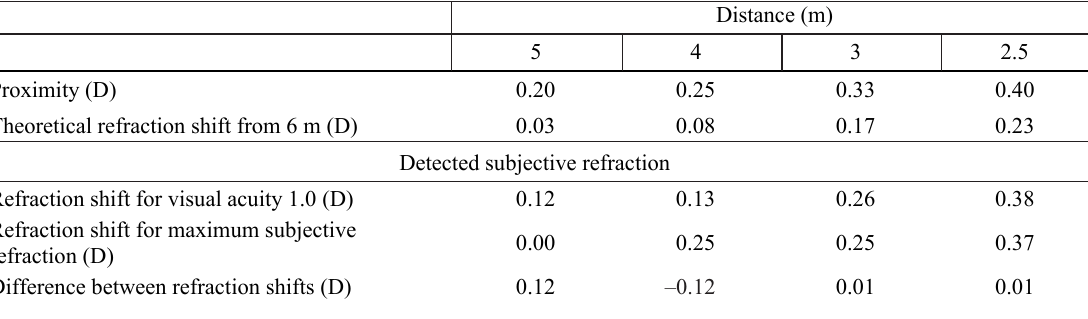
Table 1. Various refraction shifts at four viewing distances. Proximity – inverse of the viewing distance. Data for detected subjective refraction shifts are presented as medians